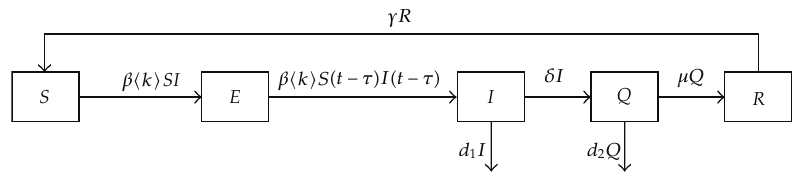
Figure 2: Framework of Model